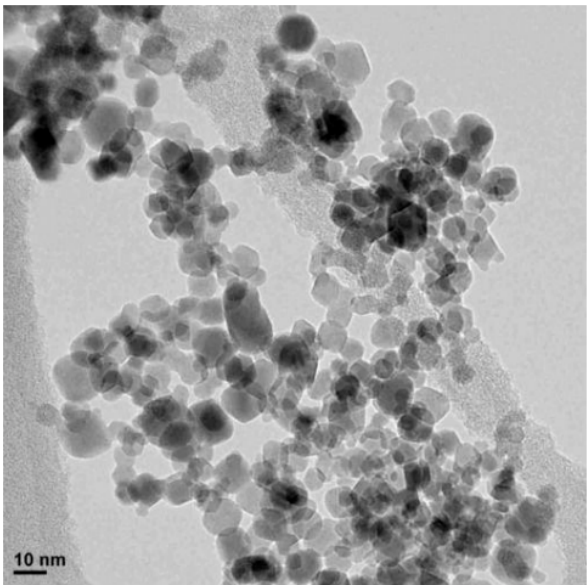
Fig. 2. The TEM micrograph of SiO 2 Nanoparticles.